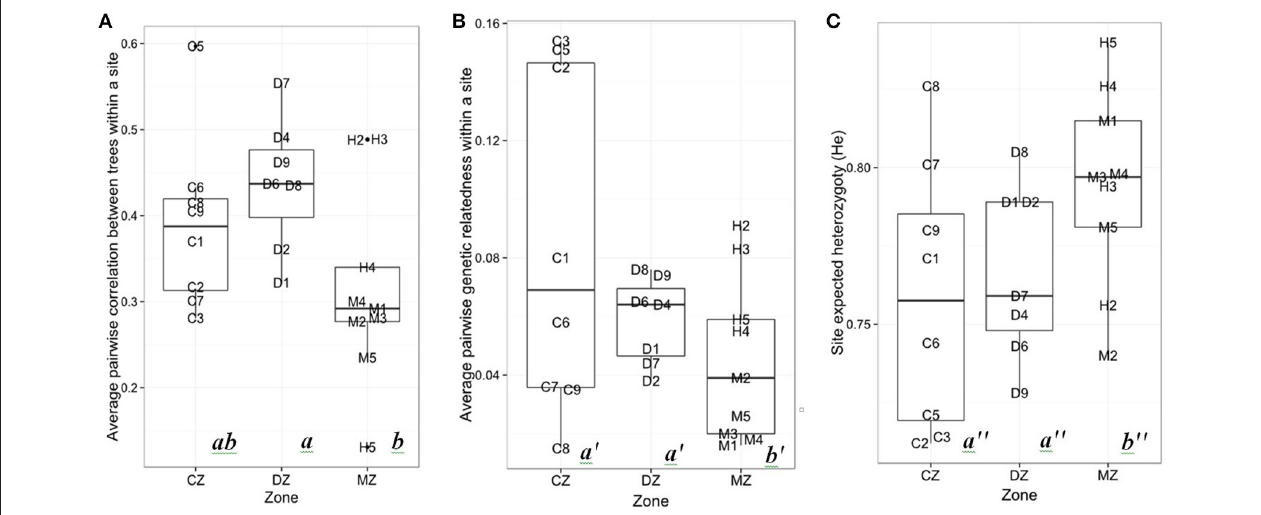
FIGURE 3 | (A) Average pairwise growth correlation between trees within each site ( r bt ), (B) average pairwise genetic relatedness, and (C) expected heterozygoty ( H e ) for the continuous zone (CZ), discontinuous zone (DZ), and marginal zone (MZ). Different letters indicate a pairwise significant difference in the mean value between clusters ( p < 0.05).